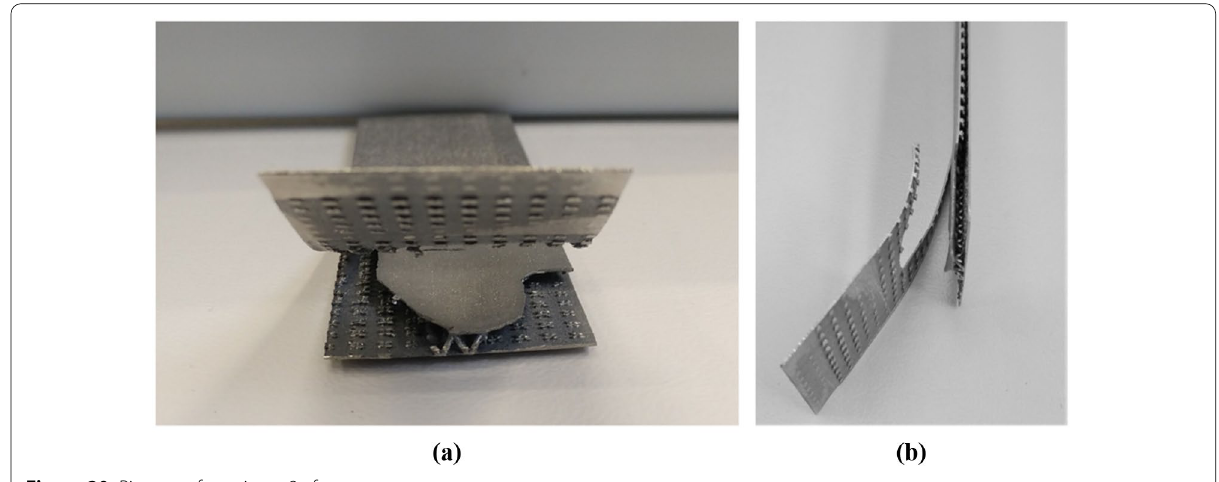
Figure 20 Pictures of specimen 3 after test